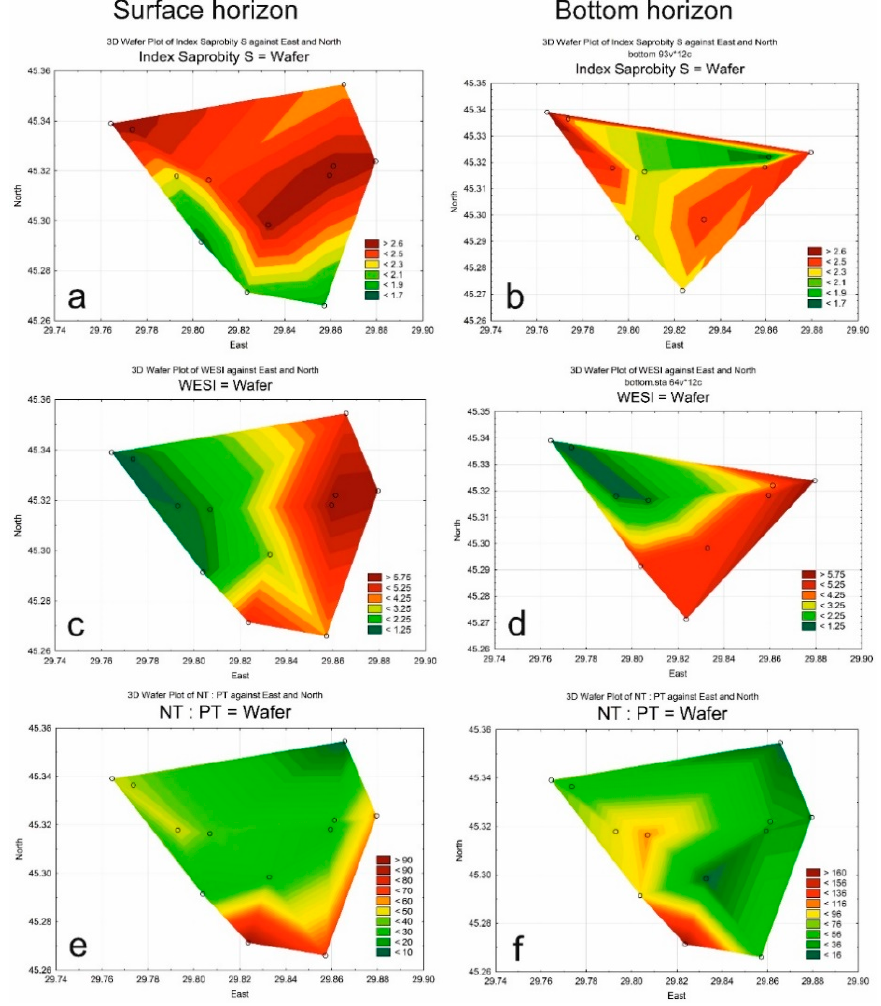
Figure 7. Statistically generated maps of the index of saprobity (S) ( a , b ), index of ecosystem state (WESI) ( c , d ) based on phytoplankton species and relation N:P ( e,f ) in the Ukrainian part of Dan- ube nearshore area in August 2018: ( a , c , e )—surface horizon; ( b , d , f )—bottom